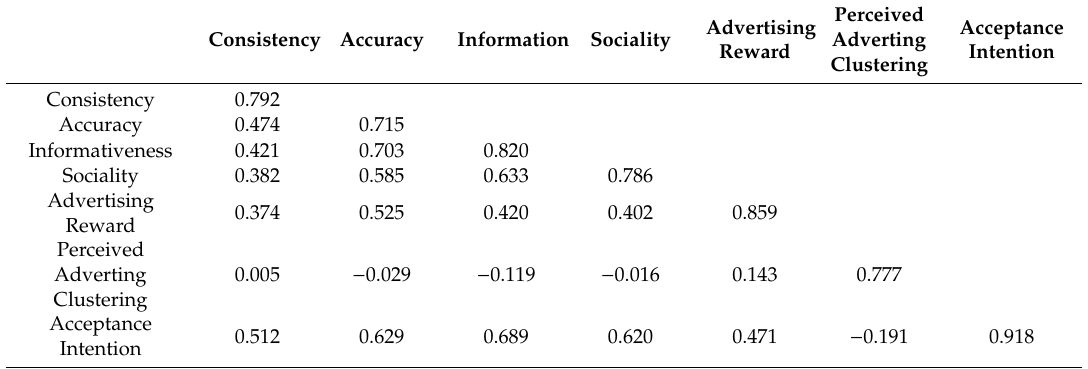
Table 3. Discriminant validity